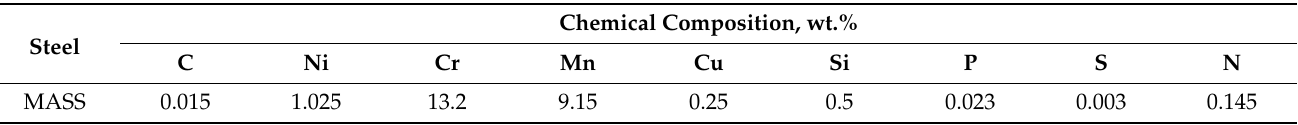
Table 1. Chemical composition of the metastable austenitic stainless steel (MASS). Chemical Composition,